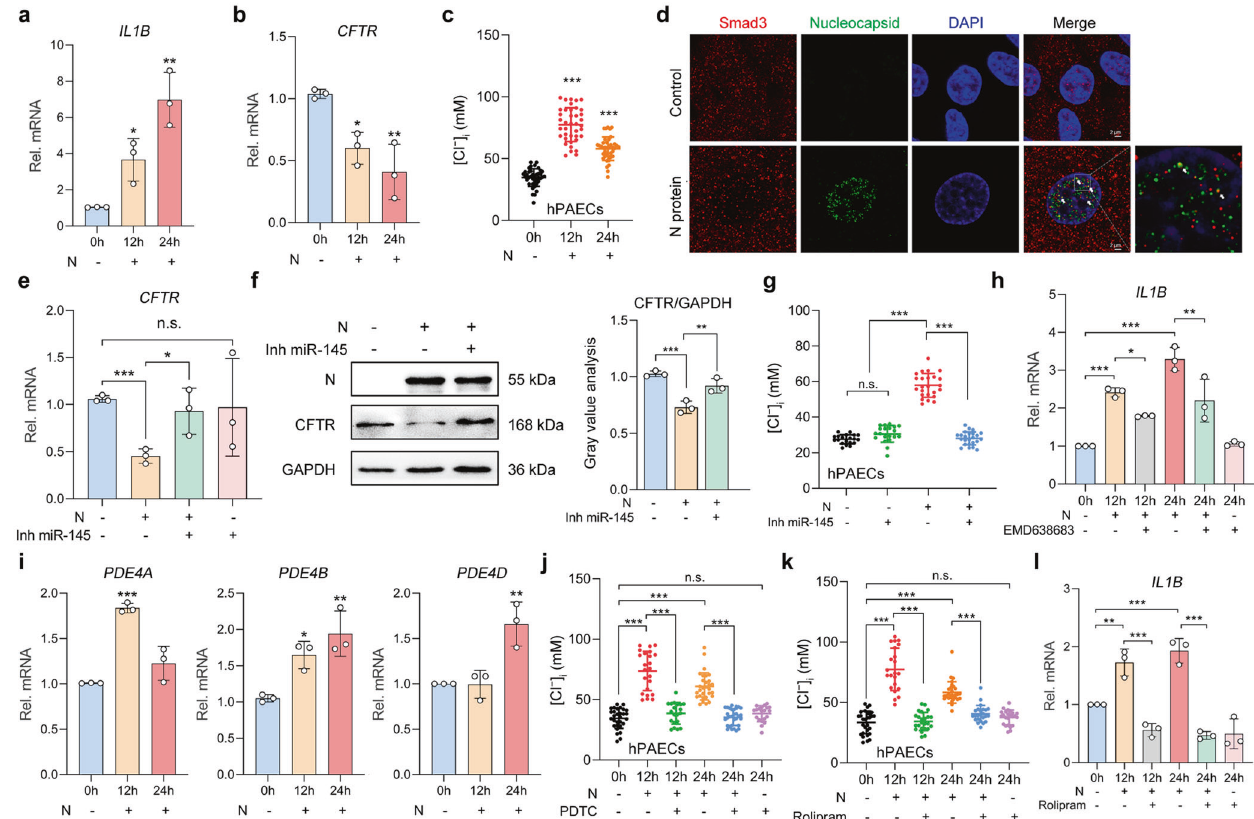
Fig. 7 Involvement of Cl − signaling mediated by SARS-CoV-2 N protein-Smad3 interactions in N protein-triggered in fl ammatory responses in hPAECs. a The mRNA expression levels of IL1B in N protein (50 μ g/ml)-stimulated hPAECs ( n = 3). b The mRNA expression levels of CFTR in N protein (50 μ g/ml)-stimulated hPAECs ( n = 3). c The changes in [Cl − ] i of hPAECs after N protein (50 μ g/ml) stimulation ( n = 39 cells from 3 individuals). d Fluorescence labeling of Smad3 (red) and N protein (green) in hPAECs with DAPI-labeled nuclei (blue) after stimulation with N protein (50 μ g/ml) for 24 h. Scale bars, 2 μ m. e The effect of Inh miR-145 (100 nM) on the mRNA expression levels of CFTR in hPAECs stimulated with N protein (50 μ g/ml) for 24 h ( n = 3). f The effect of Inh miR-145 (100 nM) on the expression of CFTR in hPAECs stimulated by N protein (50 μ g/ml) for 24 h, with the gray value analysis ( n = 3). g The effect of Inh miR-145 (100 nM) on the [Cl − ] i of hPAECs stimulated with N protein (50 μ g/ml) for 24 h ( n = 20 cells from three individuals). h The effect of EMD638683 (50 μ M) on the mRNA expressions of IL1B in N protein (50 μ g/ml)-stimulated hPAECs ( n = 3). i The mRNA expressions of PDE4 in the N protein (50 μ g/ml)-stimulated hPAECs ( n = 3). j The effect of PDTC (100 μ M) on the [Cl − ] i of the N protein (50 μ g/ml)-stimulated hPAECs ( n = 20 cells from three individuals). k The effect of rolipram (20 μ M) on [Cl − ] i of the N protein (50 μ g/ml)-stimulated hPAECs ( n = 3 cells from 3 individuals). l The effect of rolipram (20 μ M) on the mRNA expression levels of IL1B in the N protein (50 μ g/ml)-stimulated hPAECs ( n = 3). Data were shown as mean ± SD, * P < 0.05, ** P < 0.01, *** P < 0.001 compared with the control group or indicated by lines, n.s. P >